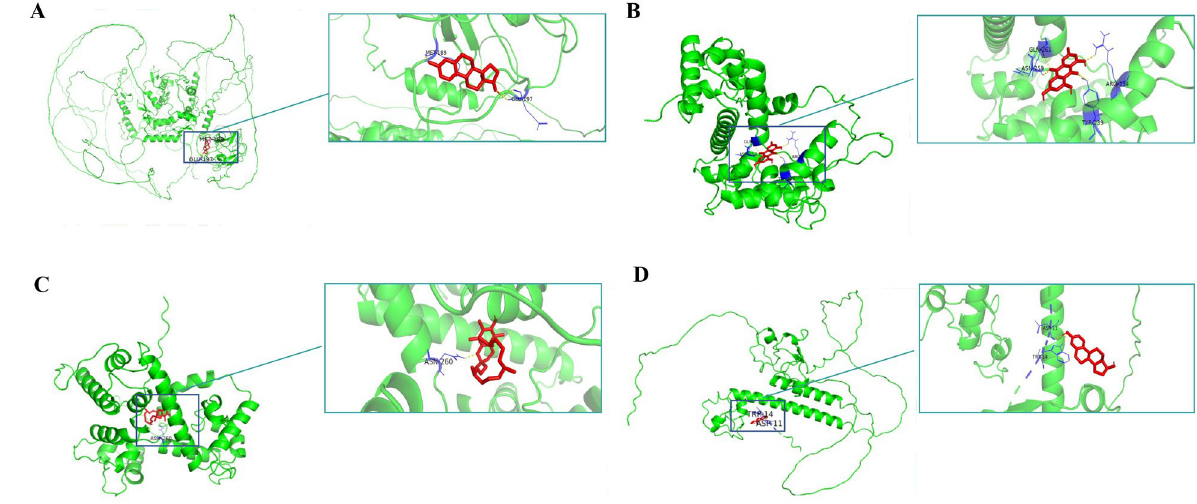
Figure 8. Molecular docking results for MECOM, RCN2, MBNL3. ( A ): A 3D view of the best-selected conformation of MECOM and 17-alpha-estradiol. ( B ): A 3D view of the best-selected conformation of RCN2 and emodin. ( C ): A 3D view of the best-selected conformation of RCN2 and alpha-tocopherol. ( D ): A 3D view of the best-selected conformation of MBNL3 and 17-beta-estradiol. Green color: protein; red color: small molecules; yellow color: conventional hydrogen